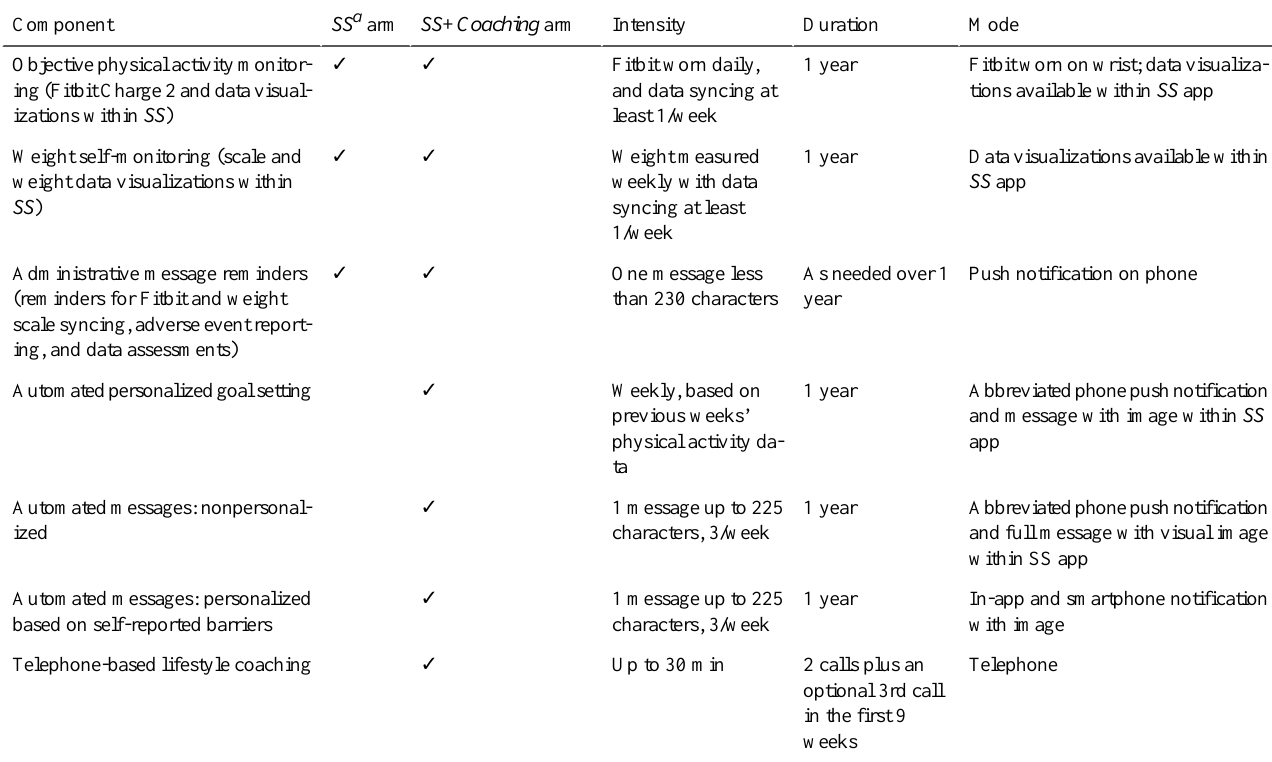
Table 1. Stay Strong components by trial